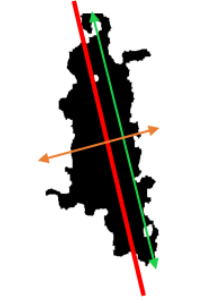
Figure 21. The main concrete spalling Table 1. The spatial information of concrete spalling